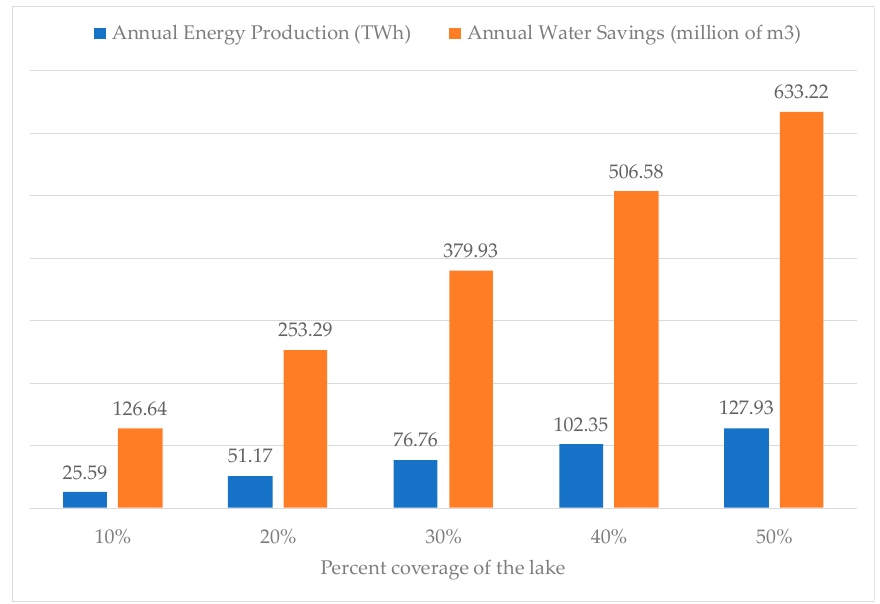
Figure 10. Simulated annual energy production (TWh) and water saving capability (millions of m 3 ) of a foam-based solar FPV system installed on Lake Mead’s surface using historical temperature data and the proposed model depending on the percentage coverage of the lake’s surface.